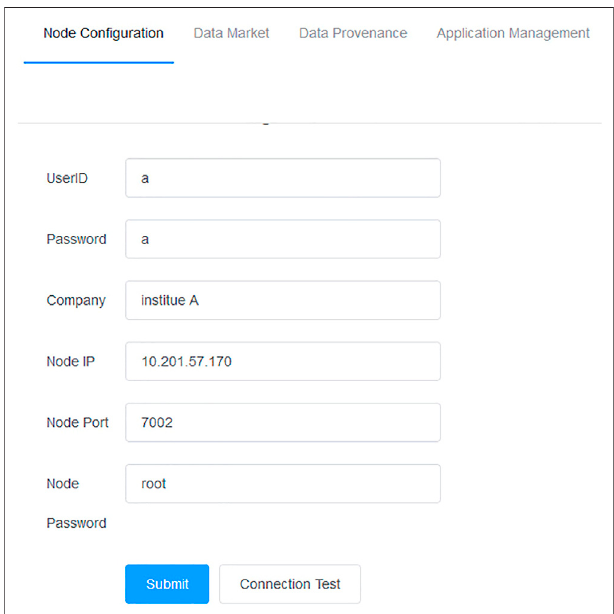
FIGURE 3 | Node con fi guration of the PHDMF. Consortium members should con fi gure the blockchain parameters within the framework.